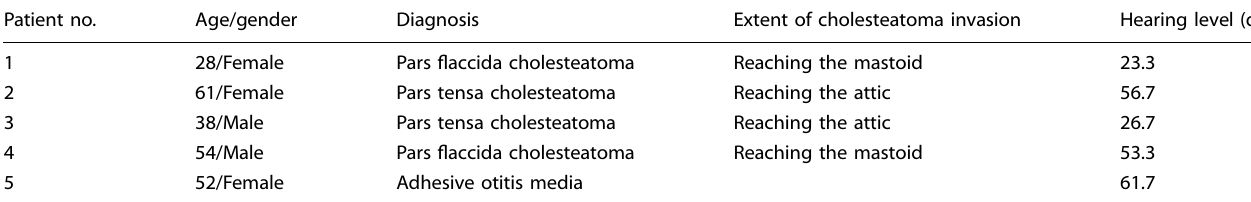
Table 1. Preoperative characteristics of patients with cell sheet transplantation Patient no.